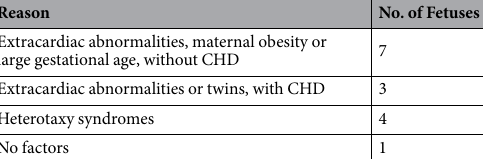
Reason Extracardiac abnormalities, maternal obesity or large gestational age, without CHD